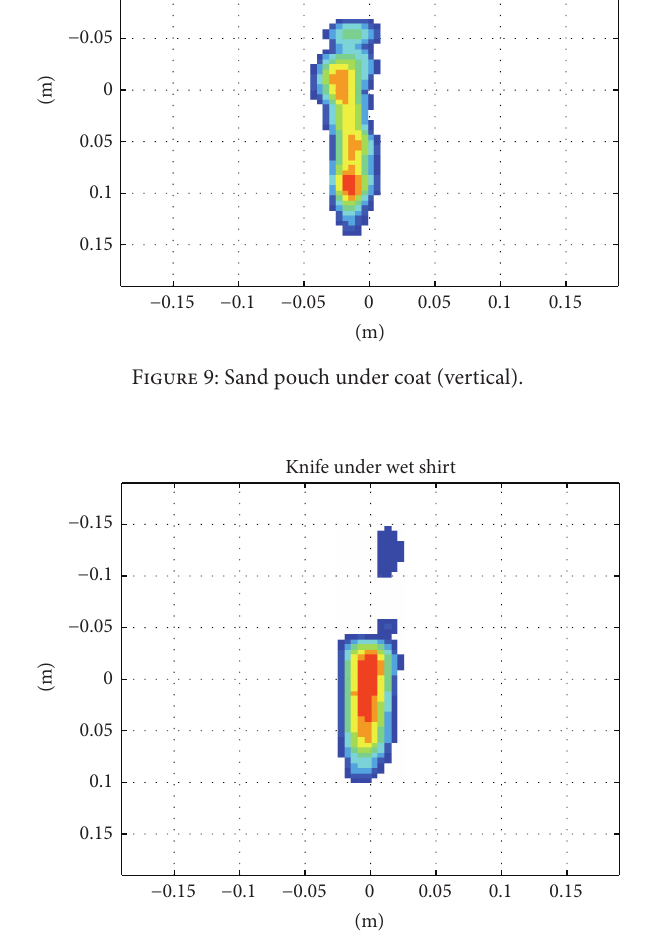
Figure 10: Knife under wet shirt (vertical).